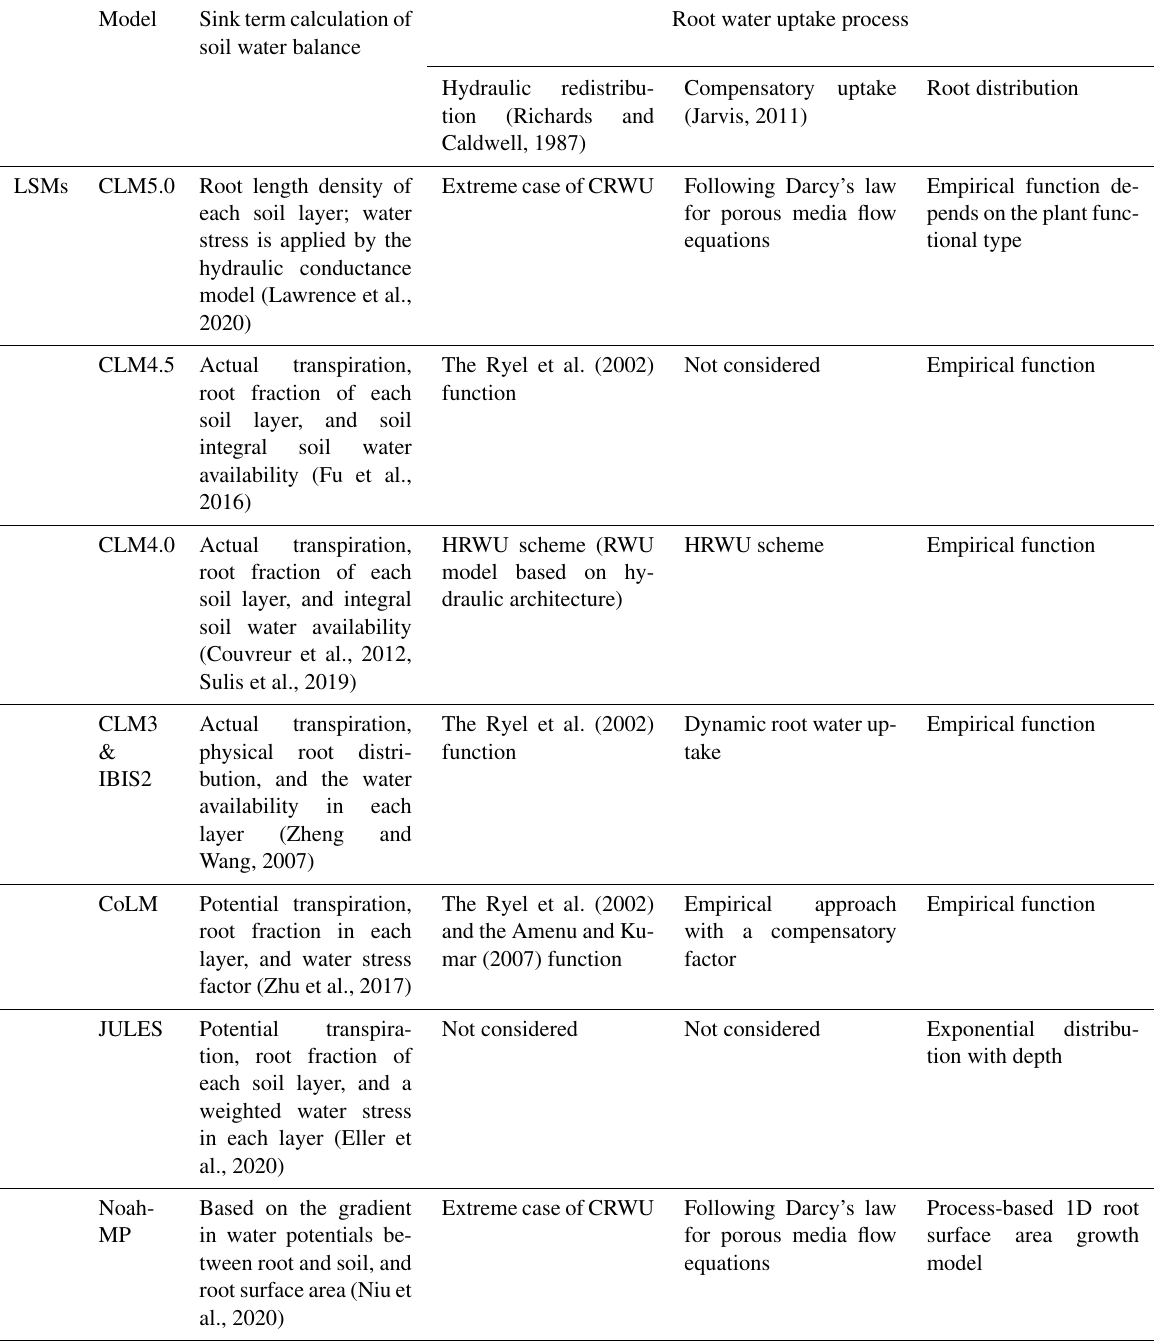
Table 1. Comparison of land surface models (LSMs) and crop models in terms of sink term calculation of soil water balance. CRWU stands for compensatory root water